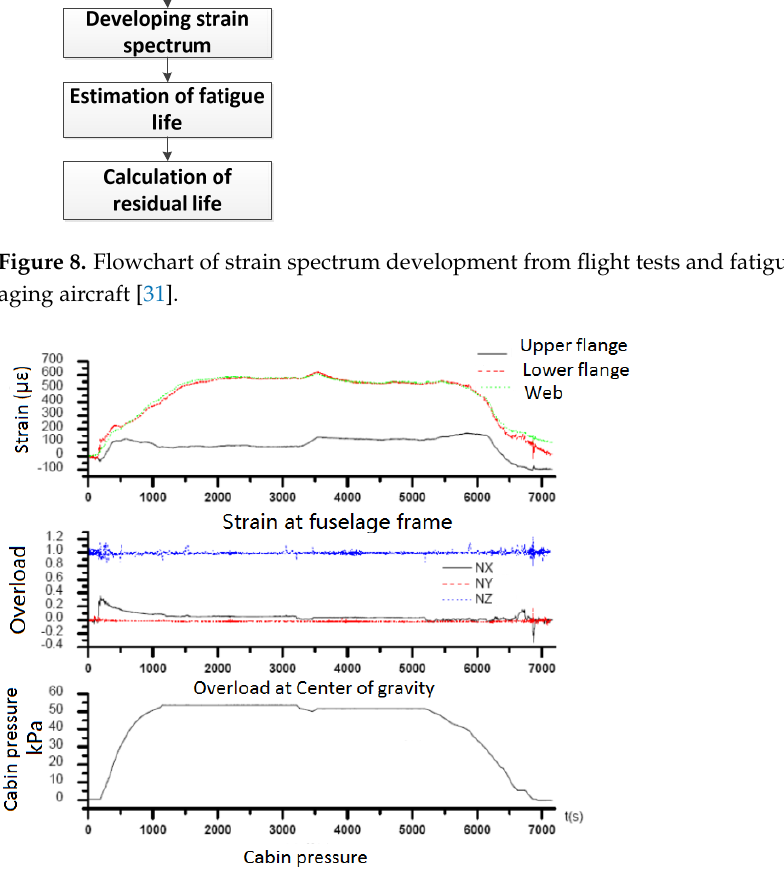
Figure 9. History of local strain and some flight parameters.